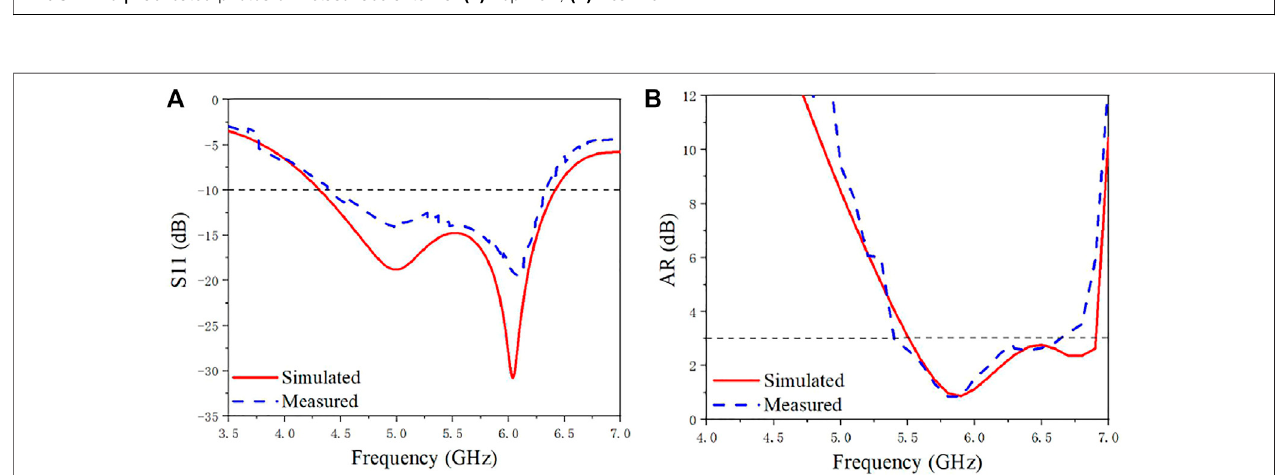
FIGURE 11 | Simulation and measurement of the S